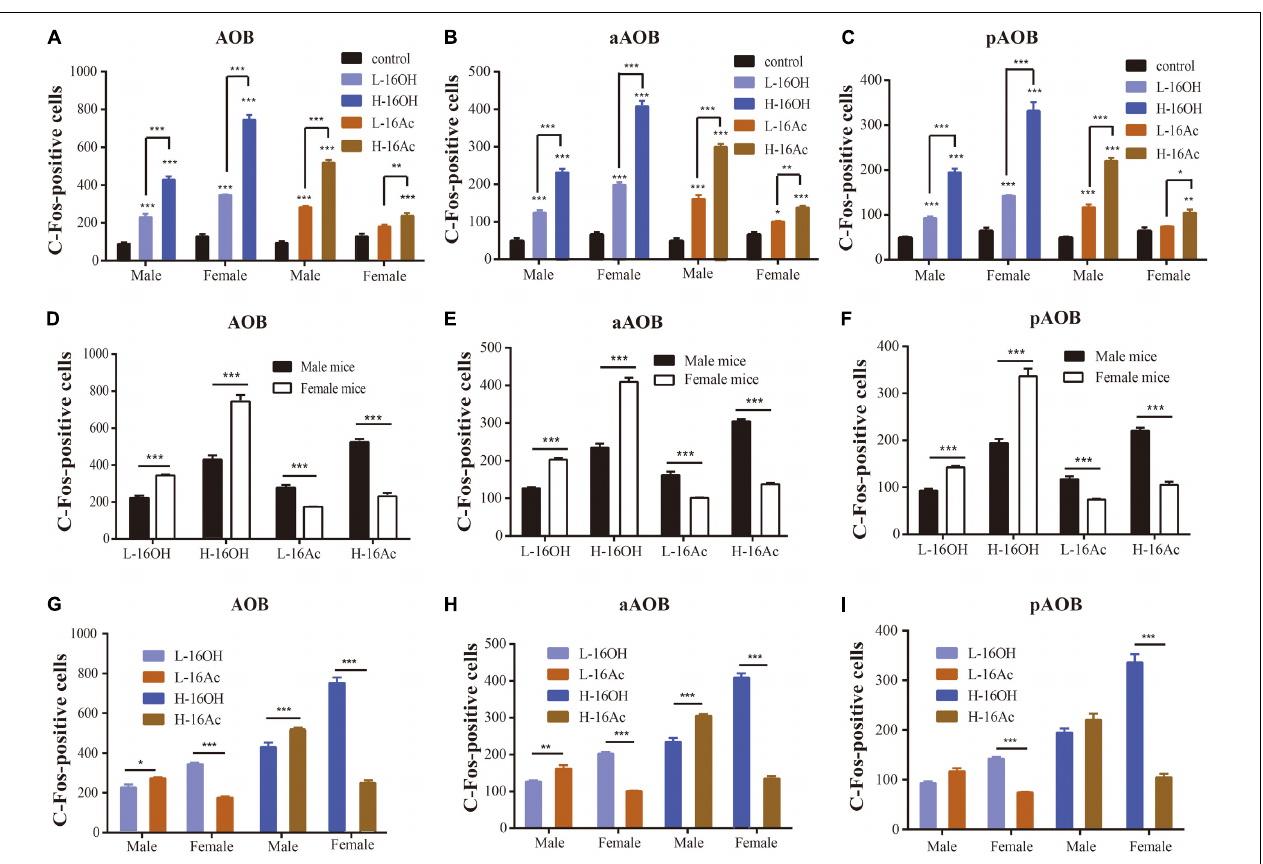
FIGURE 7 | Quantitative analysis of c-Fos+ AOB neurons of the male and female mice after exposure to 16OH and 16Ac. (A) Significantly more activated neurons were found in both male and female aAOB and pAOB following stimulation by all these four stimuli: low or high 16OH or 16Ac in comparison with the control samples except the L-16Ac in female mice (M-L-16OH vs. M-control, t = 6.780, p = 0.000; M-H-16OH vs. M-control, t = 18.717, p = 0.000; M-L-16Ac vs. M-control, t = 10.148, p = 0.000; M-H-16Ac vs. M-control, t = 24.142, p = 0.000; F-L-16OH vs. F-control, t = 11.996, p = 0.000; F-H-16OH vs. F-control, t = 34.776, p = 0.000; F-L-16Ac vs. F-control, t = 2.364, p = 0.220; F-H-16Ac vs. F-control, t = 6.200, p = 0.000). H-16OH or H-16Ac evoked more c-Fos+ AOB neurons than the corresponding L-16OH and L-16Ac, respectively, in the mice of the same sex (M-H-16OH vs. M-L-16OH, t = 11.937, p = 0.000; M-H-16Ac vs. M-L-16Ac, t = 13.994, p = 0.000; F-H-16OH vs. F-L-16OH, t = 22.780, p = 0.000; F-H-16Ac vs. F-L-16Ac, t = 3.836, p = 0.004). (B) Comparative analysis of the c-Fos+ cells in the aAOB of the same sex exposed to the same pheromone at either the low or high concentration. Significantly more activated neurons were found in both male and female aAOB following stimulation by all these four stimuli: low or high 16OH or 16Ac in comparison with the control samples whereas H-16OH or H-16Ac evoked more c-Fos+ aAOB neurons than the corresponding L-16OH and L-16Ac, respectively, in the mice of the same sex (M-L-16OH vs. M-control, t = 8.302, p = 0.000; M-H-16OH vs. M-control, t = 20.212, p = 0.000; M-H-16OH vs. M-L-16OH, t = 11.910, p = 0.000; M-L-16Ac vs. M-control, t = 12.126, p = 0.000; M-H-16Ac vs. M-control, t = 27.836, p = 0.000; M-H-16Ac vs. M-L-16Ac, t = 10.078, p = 0.000; F-L-16OH vs. F-control, t = 14.637, p = 0.000; F-H-16OH vs. F-control, t = 37.370, p = 0.000; F-H-16OH vs. F-L-16OH, t = 22.733, p = 0.000; F-L-16Ac vs. F-control, t = 3.499, p = 0.010; F-H-16Ac vs. F-control, t = 7.529, p = 0.000; F-H-16Ac vs. F-L-16Ac, t = 4.030, p = 0.002). (C) Comparative analysis of the c-Fos+ cells in the pAOB of the same sex mice exposed to the same pheromone at the either low or high concentration (M-L-16OH vs. M-control, t = 4.266, p = 0.000; M-H-16OH vs. M-control, t = 14.180, p = 0.000; M-H-16OH vs. M-L-16OH, t = 9.915, p = 0.000; M-L-16Ac vs. M-control, t = 6.651, p = 0.000; M-H-16Ac vs. M-control, t = 16.729, p = 0.000; M-H-16Ac vs. M-L-16Ac, t = 10.078, p = 0.000; F-L-16OH vs. F-control, t = 7.596, p = 0.000; F-H-16OH vs. F-control, t = 26.515, p = 0.000; F-H-16OH vs. F-L-16OH, t = 18.919, p = 0.000; F-L-16Ac vs. F-control, t = 0.950, p = 1.000; F-H-16Ac vs. F-control, t = 3.639, p = 0.002; F-H-16Ac vs. F-L-16Ac, t = 3.007, p = 0.041). (D) Comparative analysis of c-Fos+ neurons in the AOB of males versus females stimulated by 16OH or 16Ac at the low or high concentration (F-L-16OH vs. M-L-16OH, t = 7.119, p = 0.000; F-H-16OH vs. M-H-16OH, t = 17.963, p = 0.000; M-L-16Ac vs. F-L-16Ac, t = 5.881, p = 0.000; M-H-16Ac vs. F-H-16Ac, t = 16.039, p = 0.000). (E,F) Comparative analysis of c-Fos+ neurons to 16OH and 16Ac between male and female aAOB and pAOB, respectively. Female aAOB and pAOB responded more strongly to L- or H-16OH than male aAOB and pAOB, respectively, whereas male aAOB and pAOB did more strongly to L- or H-16Ac than female aAOB and pAOB, respectively (aAOB: F-L-16OH vs. M-L-16OH, t = 8.307, p = 0.000; F-H-16OH vs. M-H-16OH, t = 19.130, p = 0.000; M-L-16Ac vs. F-L-16Ac, t = 6.655, p = 0.000; M-H-16Ac vs. F-H-16Ac, t = 18.335, p = 0.000; pAOB: F-L-16OH vs. M-L-16OH, t = 4.844, p = 0.000; F-H-16OH vs. M-H-16OH, t = 13.849, p = 0.000; M-L-16Ac vs. F-L-16Ac, t = 4.187, p = 0.000; M-H-16Ac vs. F-H-16Ac, t = 11.258, p = 0.000). (G–I) Comparison of the efficacy of 16OH versus 16Ac on evoking the c-Fos response in the AOB. 16OH seemed to be more effective on the female AOB, aAOB, or pAOB than on the male counterparts while 16Ac was more effective on male AOB, aAOB, or pAOB than on the female counterparts (AOB: M-L-16Ac vs. M-L-16OH, t = 3.368, p = 0.015; M-H-16Ac vs. M-H-16OH, t = 5.426, p = 0.000; F-L-16OH vs. F-L-16Ac, t = 9.632, p = 0.000; F-H-16OH vs. F-H-16Ac, t = 28.576, p = 0.000; aAOB: M-L-16Ac vs. M-L-16OH, t = 3.825, p = 0.004; M-H-16Ac vs. M-H-16OH, t = 7.624, p = 0.000; F-L-16OH vs. F-L-16Ac, t = 11.138, p = 0.000; F-H-16OH vs. F-H-16Ac, t = 29.841, p = 0.000; pAOB: M-L-16Ac vs. M-L-16OH, t = 2.386, p = 0.209; M-H-16Ac vs. M-H-16OH, t = 2.548, p = 0.139; F-L-16OH vs. F-L-16Ac, t = 6.646, p = 0.000; F-H-16OH vs. F-H-16Ac, t = 22.559, p = 0.000). N = 6 for each group. All values are expressed as mean ± s.e.m. ∗ p < 0.05, ∗∗ p < 0.01, ∗∗∗ p < 0.001.